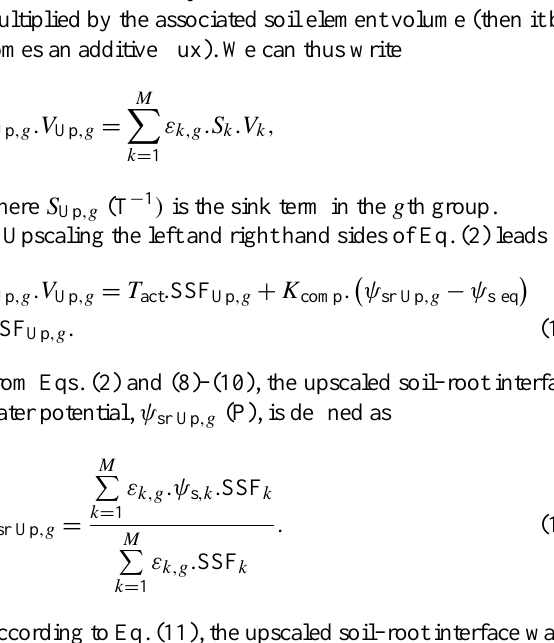
Fig. 1. Examples of the relation between ψ s ,k and ψ sr Up ,g . Cubes are soil elements whose SWP, ψ s ,k , is represented by the colour scale. Parallelepipeds are groups of three, upscaled, soil elements, whose upscaled soil–root interface water potential ψ sr Up ,g is rep- resented by the same colour scale. Green vertical lines, in elements 3–6 and groups 1 and 2, are root